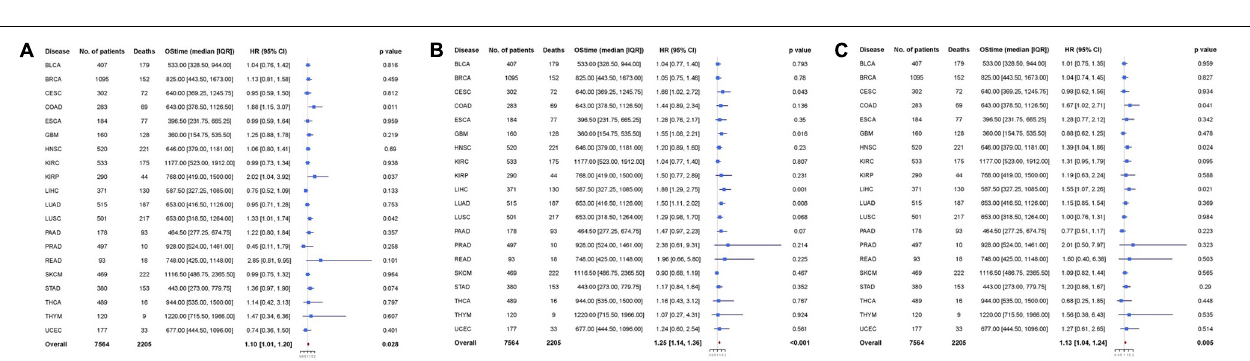
FIGURE 2 | Kaplan-Meier plots of overall survival in different SPARC/SPP1/BGLAP subgroups in the cancer types in which they had prognostic value. (A) CESC, (B) COAD, (C) GBM, (D) HNSC, (E) KIRC, (F) KIRP, (G) LIHC, (H) LUAD. p < 0.05 represents significant difference in survival outcomes.